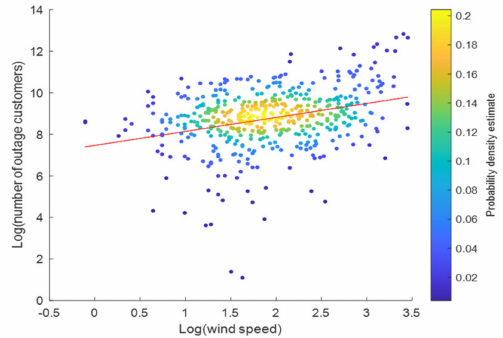
Figure 3. Average wind speed vs. the number of outage